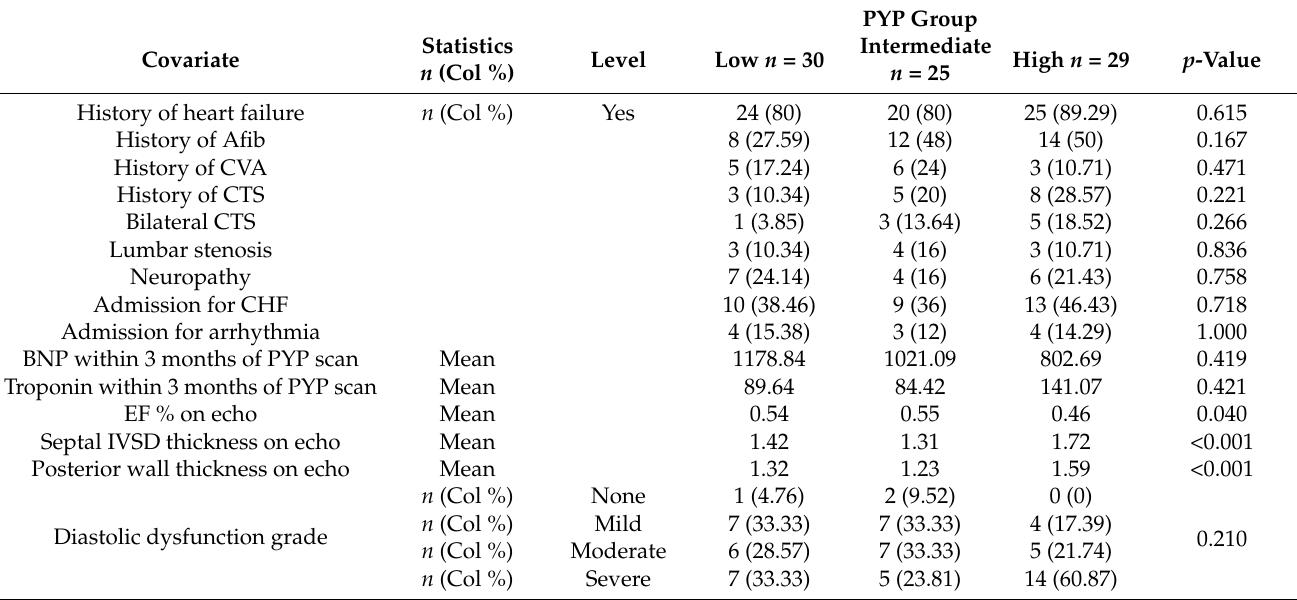
Table 2. Univariate comparisons between PYP